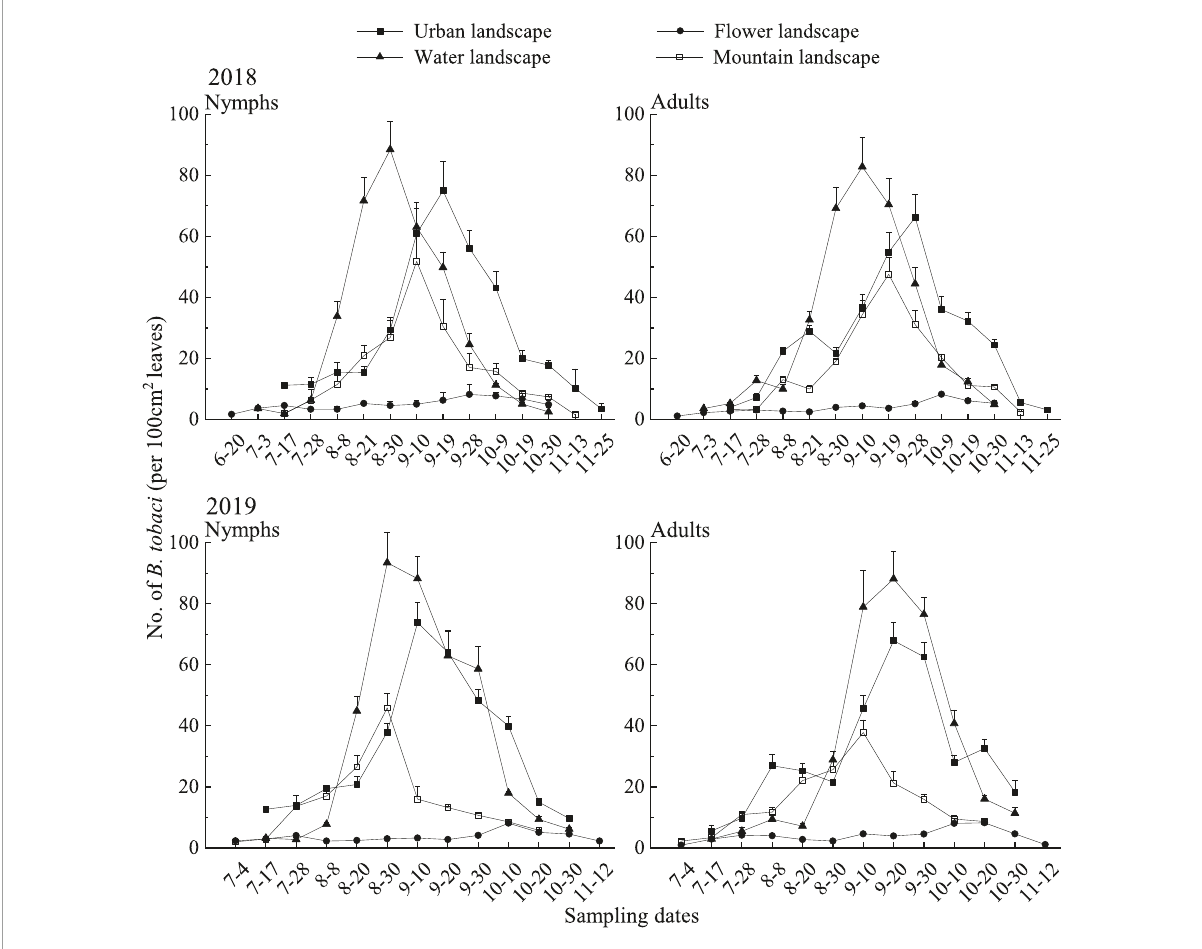
FIGURE2 Seasonal dynamics of Bemisia tabaci (mean + SE) on summer tomato fields in different agricultural landscapes at Kunming city, Yunnan province, South China, in 2018 and 2019.